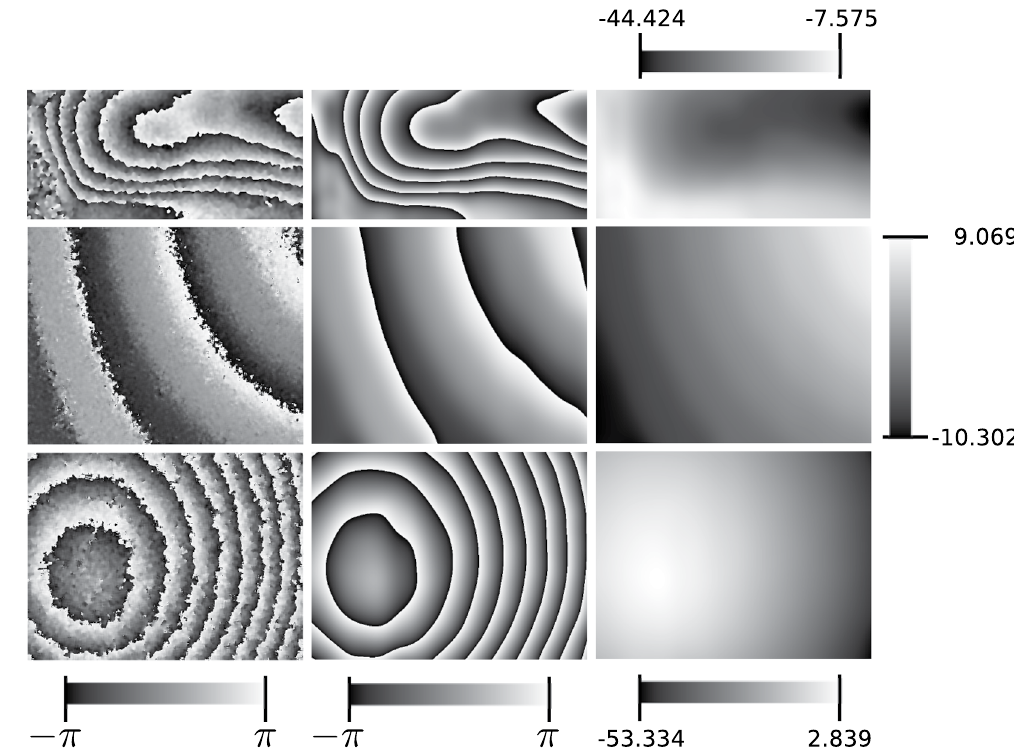
Figure 8. Test using real laboratory experiments. The first column shows the input, the second column shows the filtered wrapped phase and last column shows the corresponding unwrapped phase. All experiments are from speckle